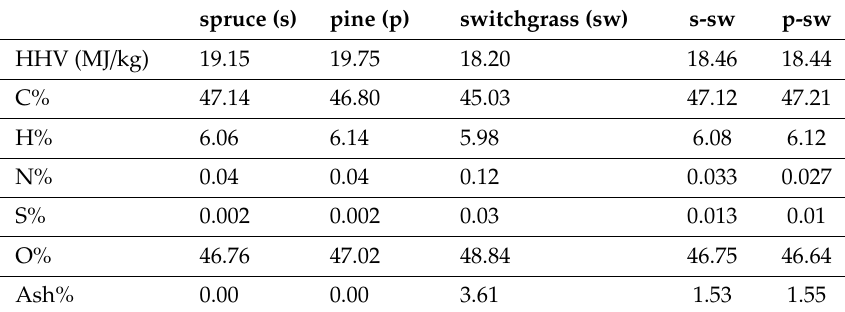
Table 1. HHV and ultimate analysis of the raw material [3]. spruce (s) pine (p) switchgrass